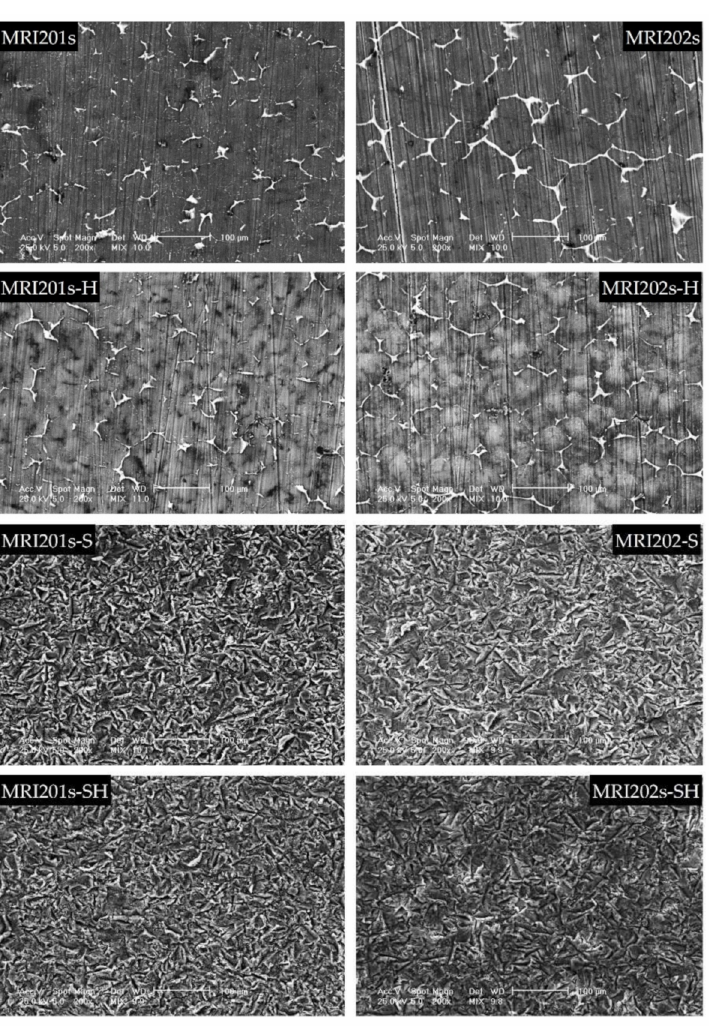
Figure 4. SEM images obtained after the surface analysis for untreated (MRI201s and MRI202s), fluo- ride treated samples (MRI201s-H and MRI202s-H), sandblasted samples (MRI201s-S and MRI202s-S) and combined treated samples (MRI201s-SH and MRI202s-SH)—scalebars are 100 microns.